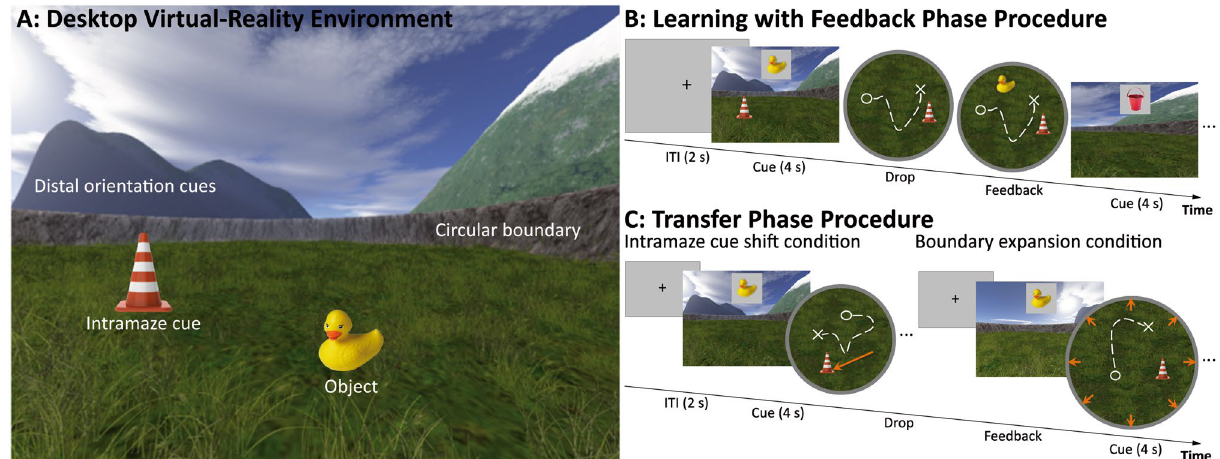
Figure 1. Schematic diagram of the desktop virtual-reality environment ( A ) and experimental procedures of the learning phase with feedback ( B ) and the transfer phase ( C ) with the intramaze cue shift and the boundary expansion condition for manipulating striatal- versus hippocampal-dependent spatial learning, respectively. The white dashed line represents possible movement paths with the white circle indicating a starting point and a white cross indicating a memorized location where the participant placed the respective object by pressing a button (see text for